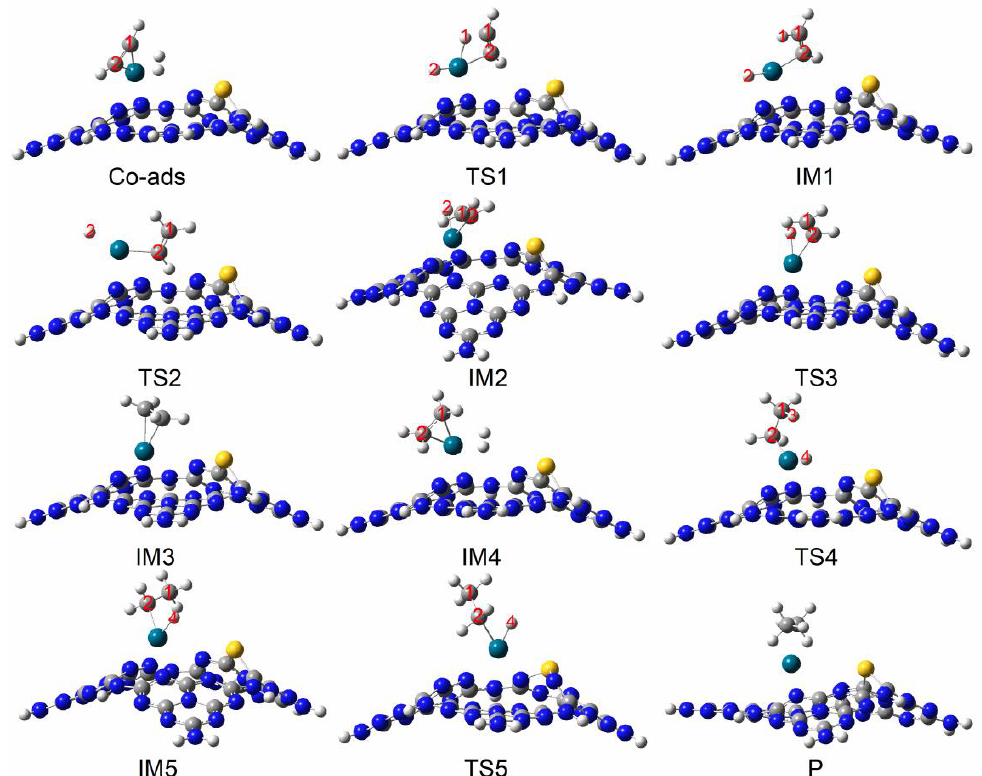
Figure 6. The reaction mechanism of acetylene hydrogenation catalyzed by S-doped N site and their corresponding structures.